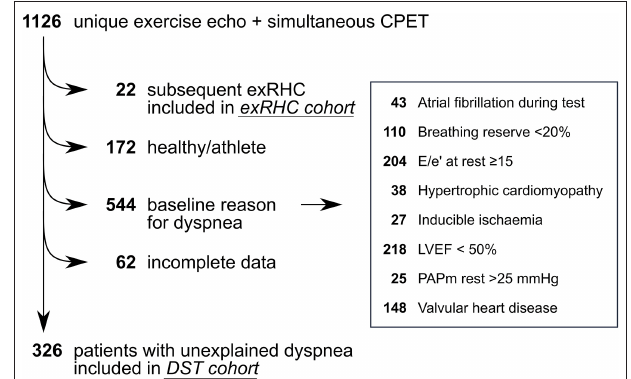
FIGURE 1 | Study flow. We screened 1,126 unique patients who underwent simultaneous exercise echocardiography and cardiopulmonary exercise test. Patients who underwent subsequent exRHC ( n = 22) were included in the exRHC cohort. Patients with unexplained dyspnea were included in the DST cohort ( n = 326). We excluded healthy subjects ( n = 172), patients with incomplete data ( n = 62) and patients with a baseline reason for dyspnea ( n = 544). Note that some patients had more than 1 reason for dyspnea. Valvular heart disease was defined as more than mild valvular stenosis, more than moderate left-sided valvular insufficiency, or previous valvular surgery. DST, diastolic stress test; exRHC, exercise right heart catheterization; LVEF, left ventricular ejection fraction; PAPm, mean pulmonary artery